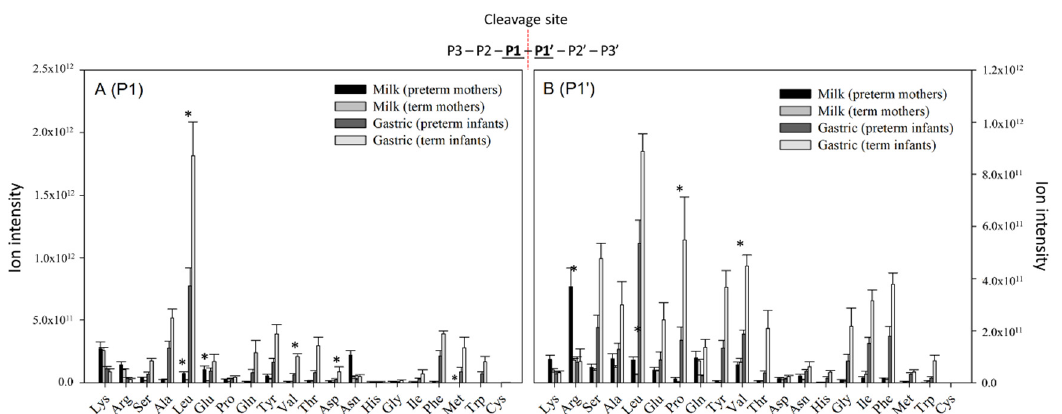
Figure 7. Total ion intensity of peptides distributed according to their P1 ( A ) and P1 ′ ( B ) cleavage site amino acid in term and preterm infants’ mothers’ milk and their gastric samples. Asterisk marks significant difference between preterm and term infants. P3–P3’ are the amino acids positioned around the cleavage site.